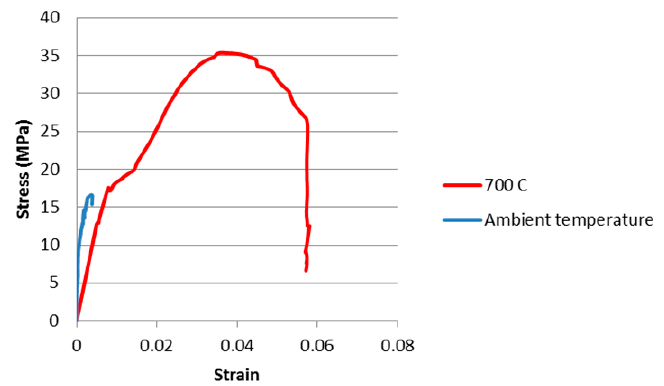
Figure 4. HTC 6A compression test curves, undertaken at ambient and 700 °C.